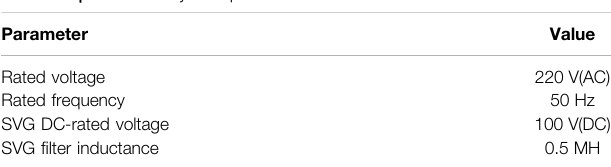
TABLE 1 | Simulation system